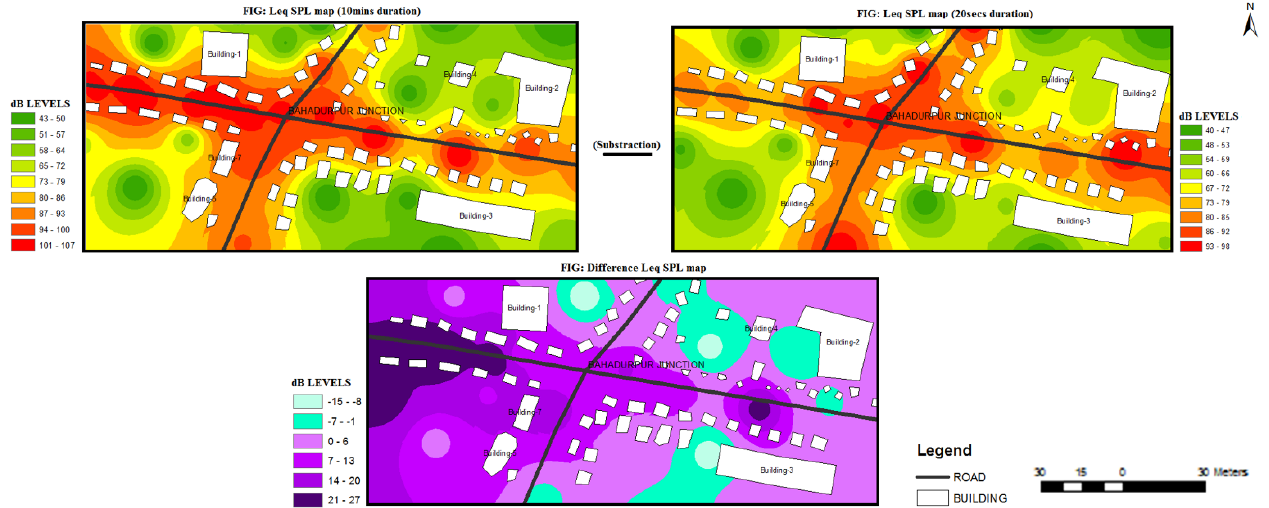
Figure 18. Long vs. short noise sampling duration based noise prediction and their difference at the M4 time interval (3–5 PM) for the Bahadurpur study area.